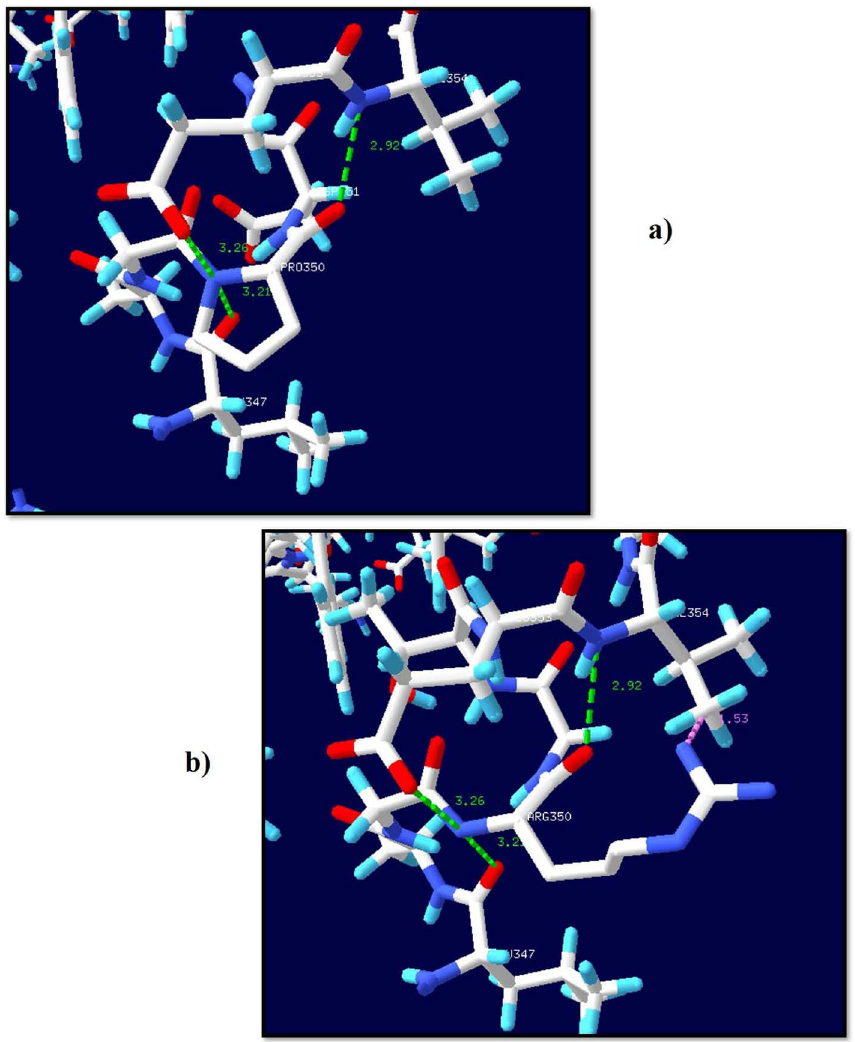
discontinuous lines. ( b ) R350 forms a clash with V354 (1.53 Å) presented by pink discontinuous line along with the three